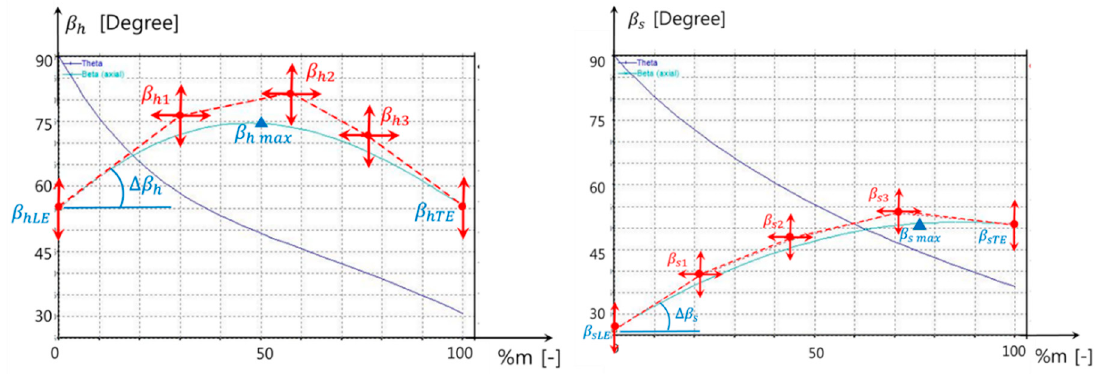
Figure 2. Beta distribution at hub and shroud curve.